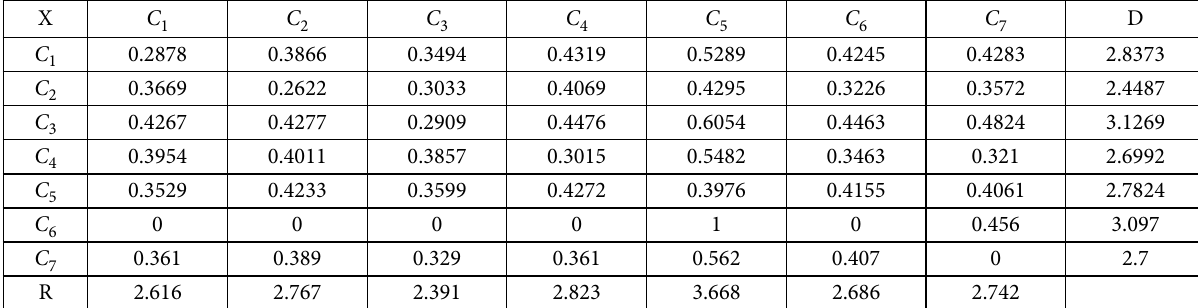
Table 4. The total-relation matrix for supplier criteria assessment